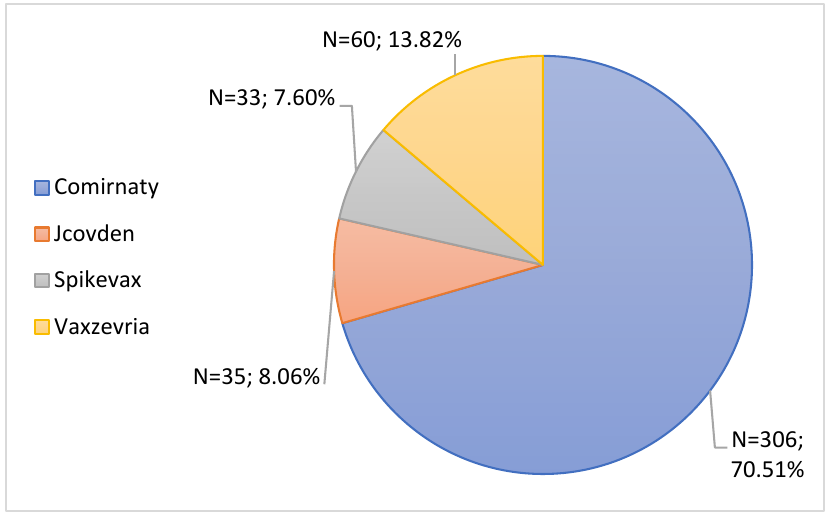
Figure 8. Characterization of notifications according to seriousness.